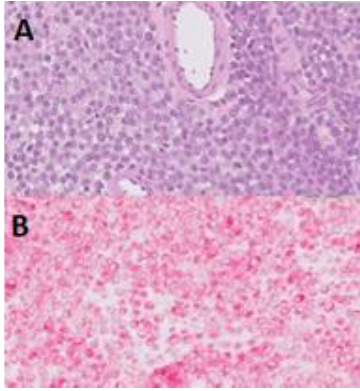
Figure 2. Histological examination of tumor biopsy. Neoplasm is composed of pleomorphic cells with vescicular nuclei, eosinophilic nuclear pseudoinclusion, and moderate cytoplasm ( A , B ).